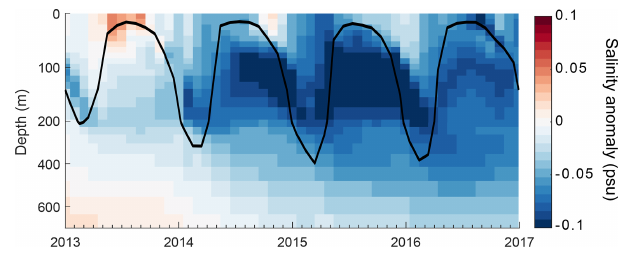
Figure 13. Salinity anomalies over depth relative to the 1992–2015 monthly climatology (colour; psu), averaged over the cold blob re- gion in ECCOv4-r4 for the period leading up to and during the 2015 cold anomaly. The MLD is also shown (black line, m). Note the non-uniform spacing of the vertical